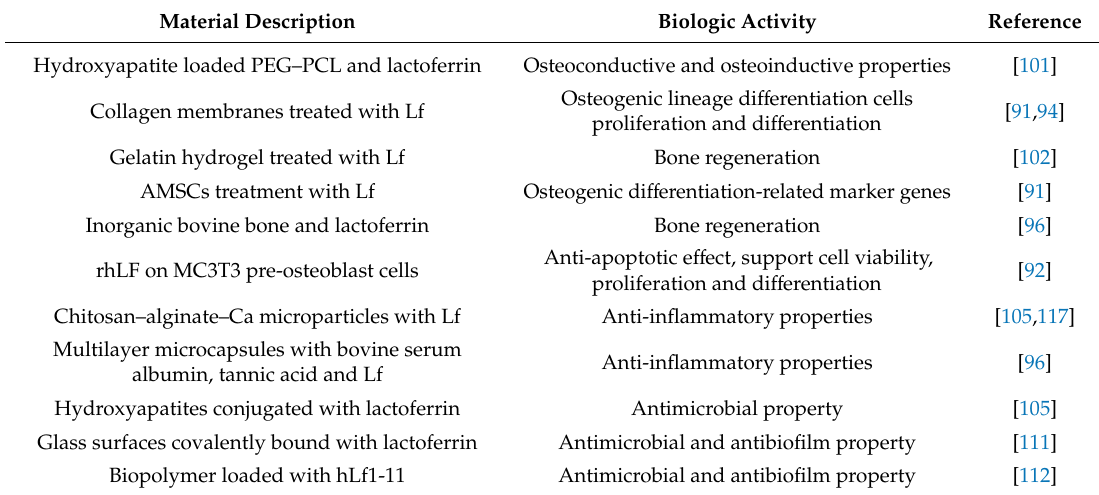
Table 1. Biologic activity of Lf-coated